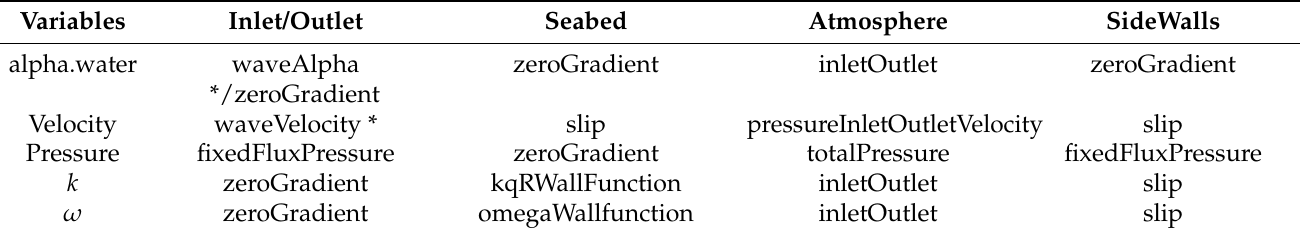
Table 3. Boundary conditions of the computational